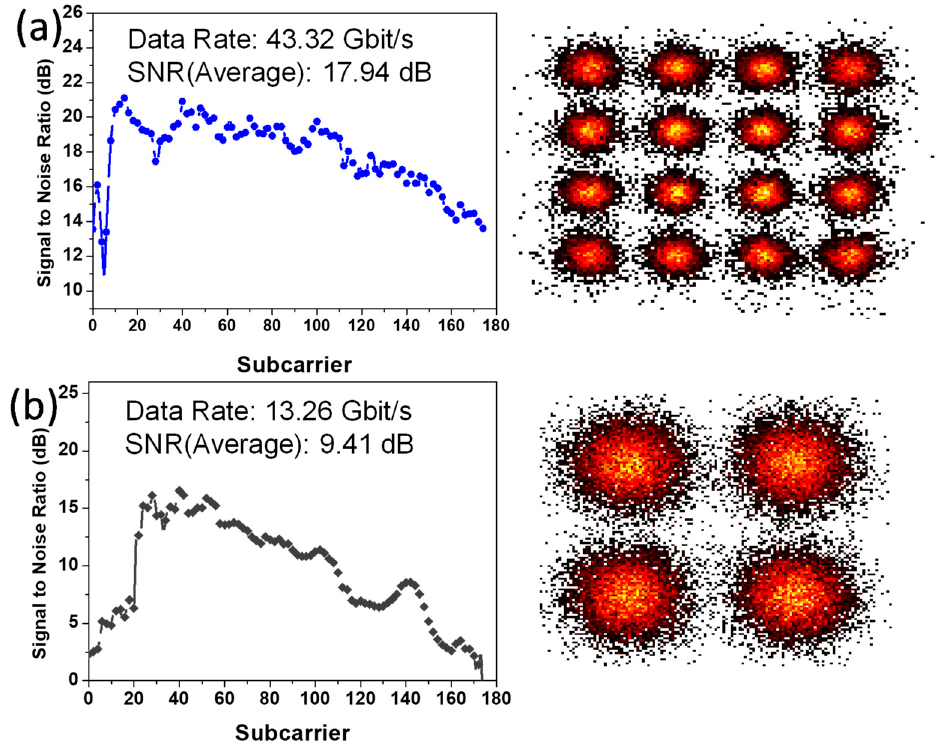
Figure 10. Measured SNRs of NOMA ( a ) Data 2 and ( b ) Data 1 over all the 170 OFDM subcarriers at MDM TE 0 mode, with corresponding constellation diagrams of the NOMA Data 2 and Data 1 .